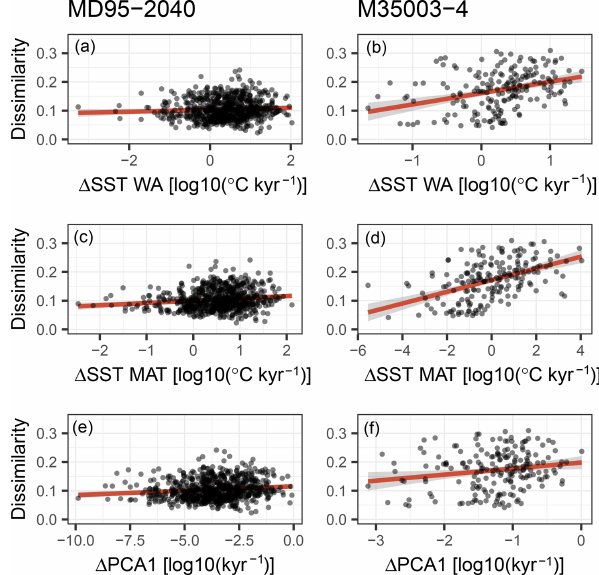
Figure 8. A possible role for sediment mixing in determining ana- logue quality (dissimilarity; see Fig. 6). Sediment mixing would create poor analogue assemblages when different species communi- ties are mixed. The difference between subsequent species commu- nities in the sediment core is defined here in two ways: (i) as the dif- ference in inferred temperature (a–d) and (ii) as the first derivative of the loadings of the first axis of a principal component analysis (PCA) on the species abundances (e–f) . A linear regression includ- ing a 95% confidence interval is shown as a red line with grey shad- ing. Only for core M35004-3 is a weak positive relationship visible, indicating that sediment mixing is a possible contributor to creating poor analogue assemblages but cannot explain them